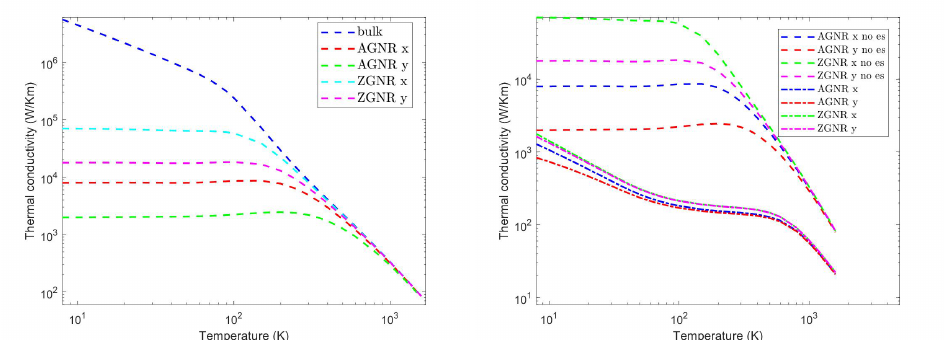
Figure 18. The steady-state thermal conductivity for A- and ZGNRs in the x- and y-direction. ( Left ): only with edge scattering. ( Right ): with and without bs-scattering. L y = 80 nm.